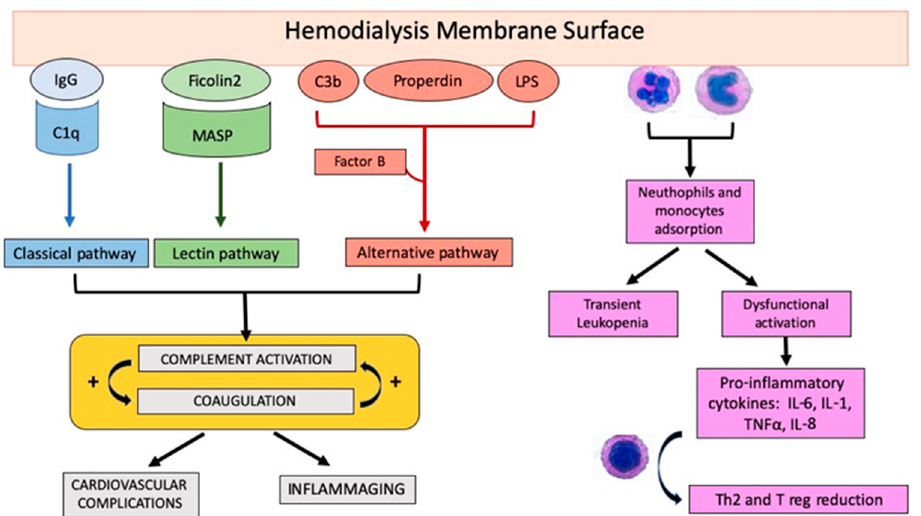
Figure 2. Innate immune activation on hemodialysis membrane surfaces. Hemodialysis filters can adsorb several complement components. The adhesion of circulating IgG can induce the classical pathway activation by the binding of C1q. The adsorption of Ficolin-2 to the dialyzer can lead to the lectin pathway by the binding of circulating mannose binding lectin-associated serine proteases (MASPs). Furthermore, properdin, C3b, albumin, lipopolysaccharide (LPS), or other bacterial components in dialysis solutions or hemodialysis patient bloodstream can promote the alternative route activation after the stabilization mediated by circulating factor B. The adsorption by polysulfone membranes of regulatory components as factor H, a crucial inhibitor of C3 convertase and C3b, and clusterin, able to prevent terminal pathway activation, significantly enhances the alternative pathway activation. Complement activation will result in a higher serum increase of anaphylotoxins C3a and C5a, augmented levels of soluble C5b-9, and the induction of coagulation. IL, interleukin, TNF; Tumor Necrosis Factor. Complement effectors directly boost coagulation. For example, C3a anaphylatoxin activates platelets, enhancing their aggregation and adhesion, and C5a increases blood thrombogenicity, mainly through the upregulation of TF and PAI-1 expression on neutrophils and monocytes. From the other side, the coagulation component thrombin cleaves C3 to C3a and C3b, and C5 to C5a and C5b, thus amplifying the activation of complement. The interplay between complement and coagulation system